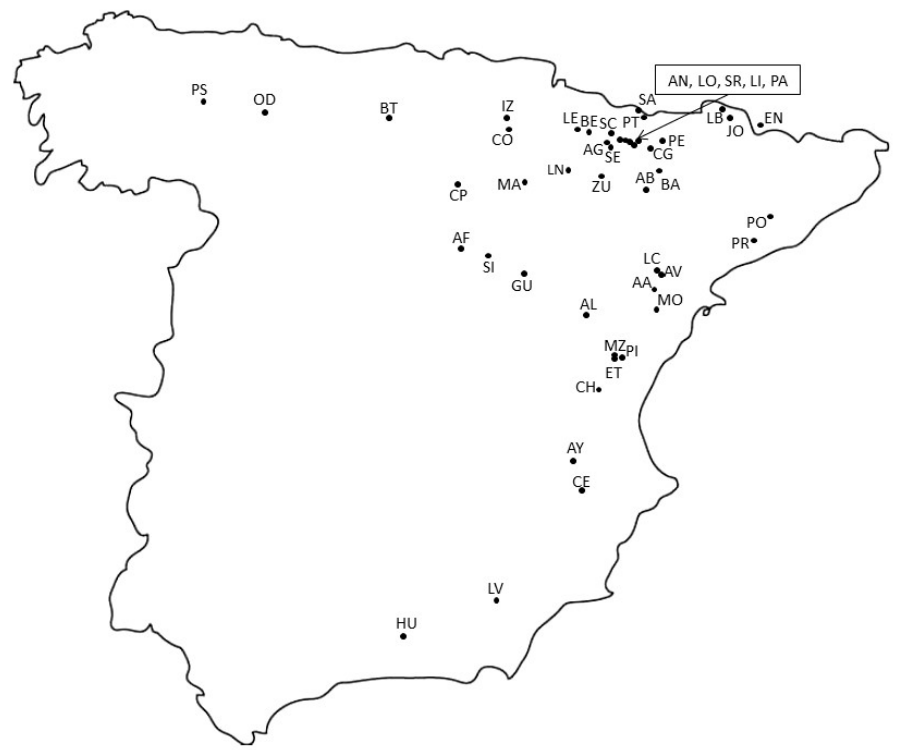
Figure 1. Location of the 46 natural populations of bearberry sampled in this study. Phytochemical analysis was performed using plant material from 42 locations, while genetic and cytogenetic studies were performed using plant material from 37 and 35 locations, respectively. Population codes are detailed in Table S1.